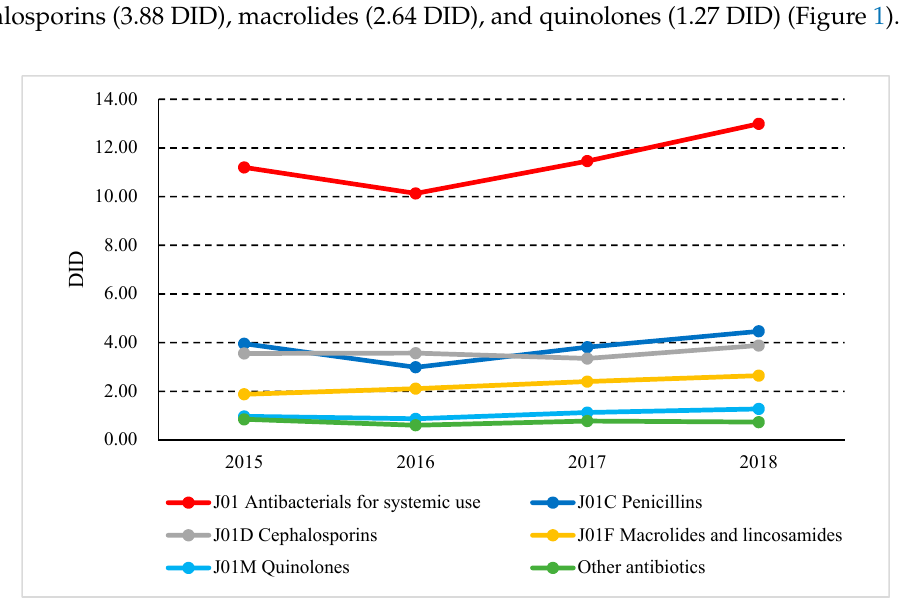
Figure 1. Antibiotic consumption in Shaanxi Province, western China, 2015–2018. (DDDs, defined daily doses; DID, DDDs per 1000 inhabitants per day).